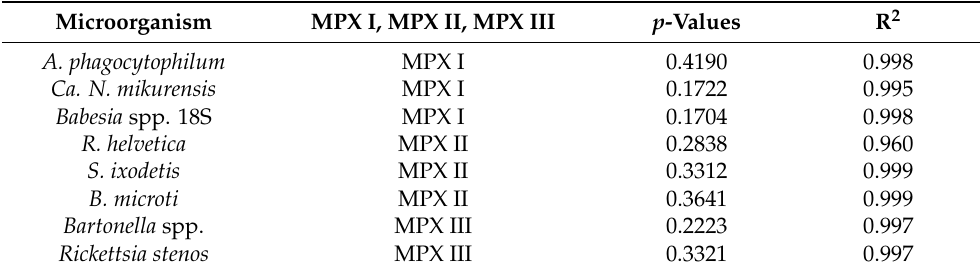
Table 4. Overview after testing the spiked blood to determine the matrix effect per target.